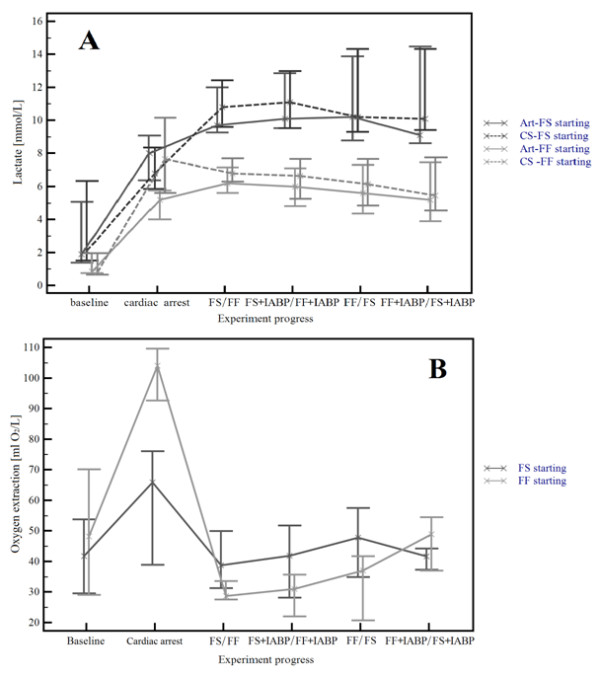
Coronary artery and coronary sinus lactate levels and myocardial oxygen extraction during the protocol. Lactate levels (panel A) steeply rise during cardiac arrest in both arms. In the FS arm, lactate rise persists even during the first ECMO treatment and reaches significantly higher plateau levels than in the FF arm both for arterial and CS values (P = 0.016 and P = 0.035, respectively). Significantly higher levels in the FS arm persist during the rest of the protocol, however in both arms a downward trend can be detected, though more pronounced in the FF arm. Myocardial oxygen extraction in ml O2/L (panel B) markedly increases during cardiac arrest followed by a steep decline after starting both ECMO regimens. Values after ECMO start are not significantly different (see text).